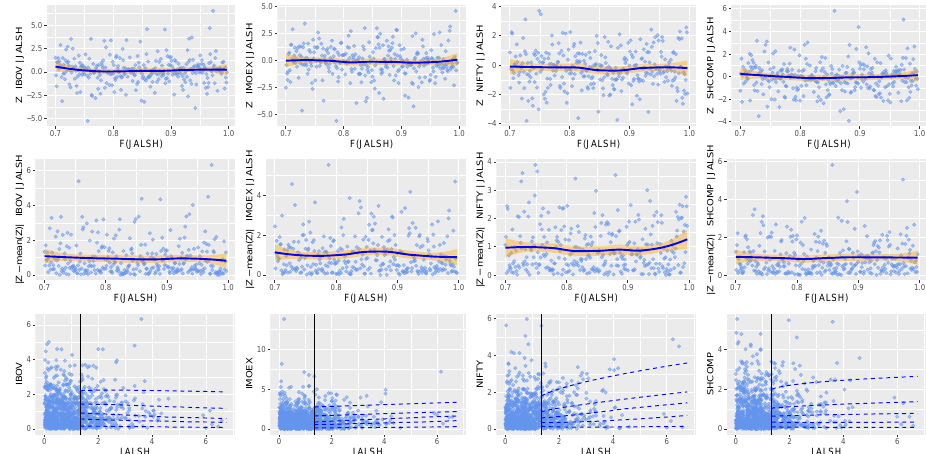
Figure A6. Dependence model diagnostics: conditioning on the JALSH